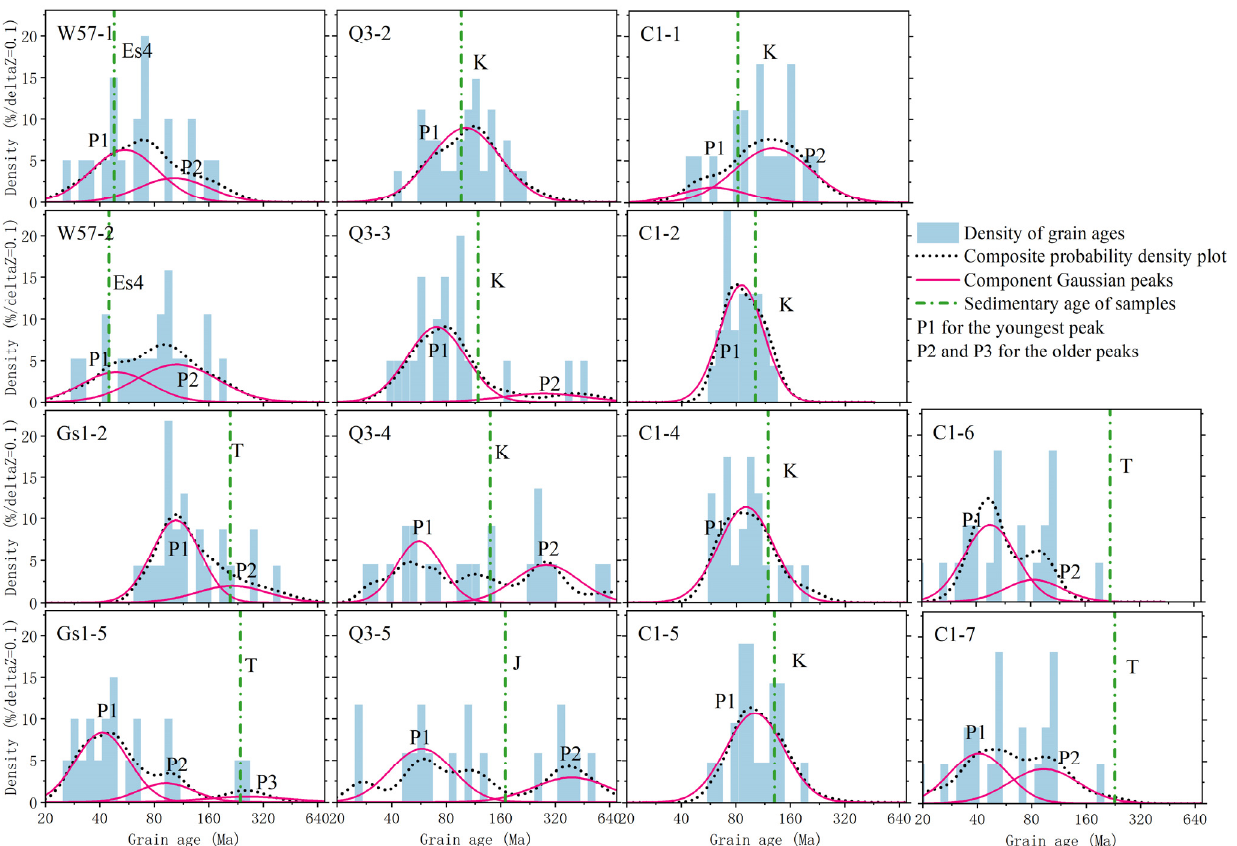
Figure 4. Best-fit Gaussian peaks for a composite probability density plot. Trassic (T), Jurassic (J), Cretaceous (K), Shahejie formation (Es4), P1, P2 and P3 are three age groups.